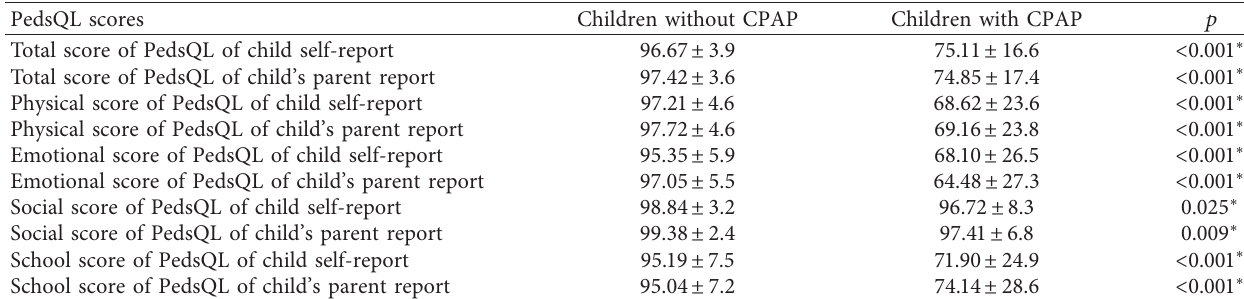
Table 4: The comparison of the PedsQL scores of